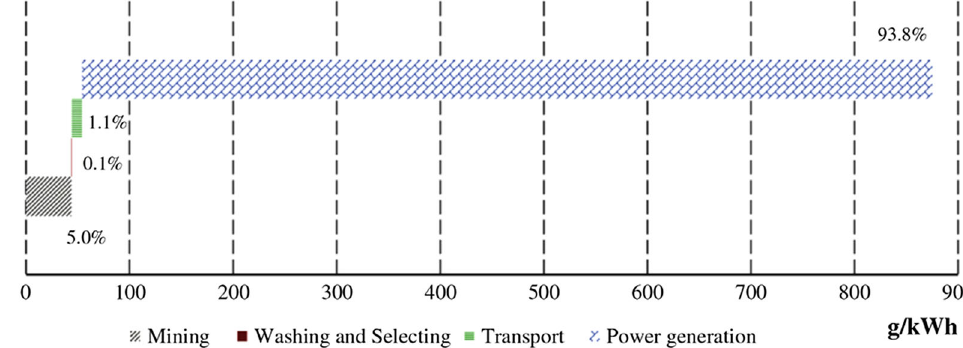
Fig. 7 Proportion of CO 2 emissions of various processes in the coal-to-power energy chain (Yu et al.